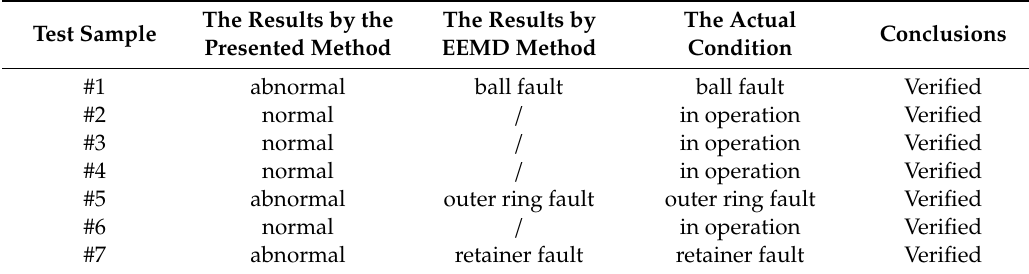
Table 4. The conditions of flywheels